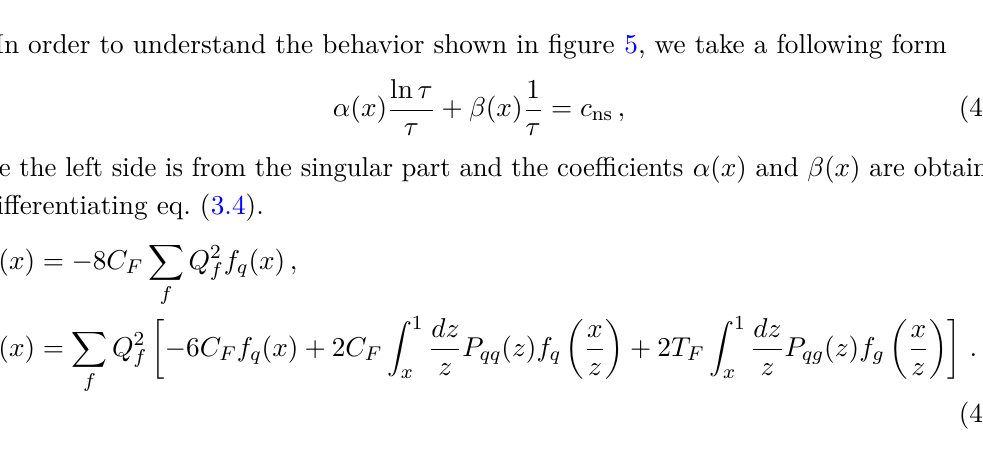
Figure 5 . Values of τ jt (solid lines) and τ b (dashed lines) when the singular and nonsingular parts cross each other as a function of x at Q = 15 GeV (black), 30 GeV (orange), and 45 GeV (green). The color density plot represents the portion of the contributions from the nonsingular part to the total differential cross section at Q = 15 GeV for τ jt . An approximate crossing (dotted gray lines) are obtained by making use of eq. (4.4) with the values of c ns between 0 and − β ( x )